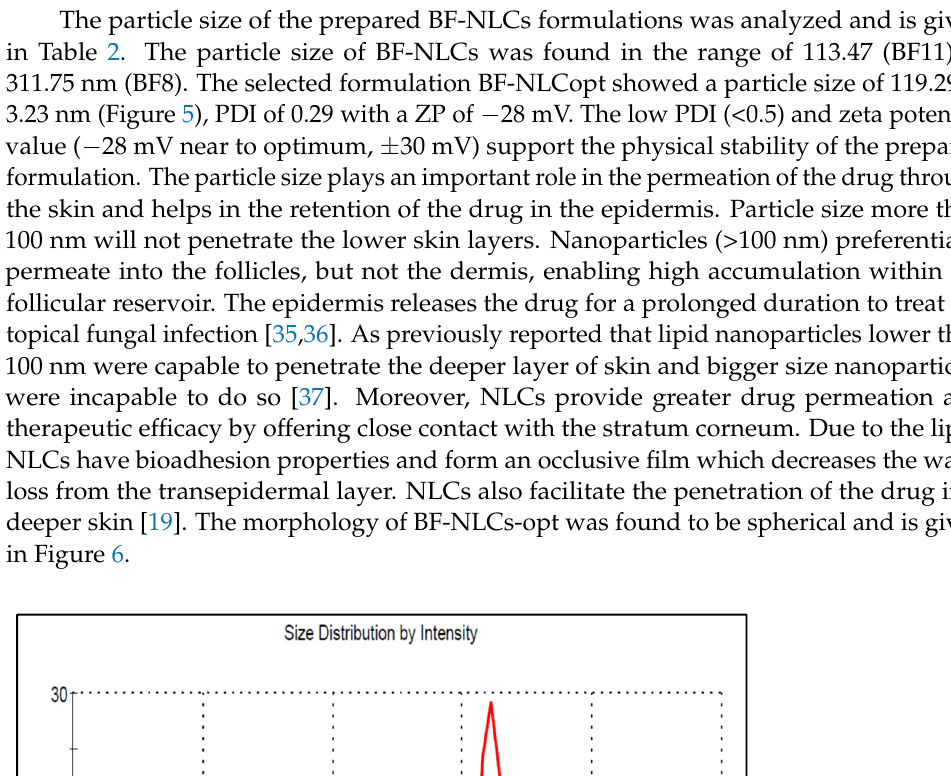
Figure 6. Surface morphology image of BF-NLCopt. 3.8. Entrapment Efficiency The entrapment efficiency of the prepared BF-NLCs was determined by the indirect method and the data are given in Table 2. The maximum entrapment efficiency was found in the formulation BF1 (66.74%) to BF7 (87.42%). The selected optimized formulation BF- NLCopt showed an entrapment efficiency of 86.35 ± 4.11%. The selected formulation showed a drug load of 11.21 ± 0.67%. NLCs were prepared with a blend of solid lipid and liquid lipid. The solid lipid encloses the oil droplets of liquid lipid which solubilizes the greater amount of drug and helps to get high entrapment and loading. The presence of liquid lipid in the NLCs affects the loading and entrapment by creating imperfections in the order crystal structure and gives more space to accommodate a greater amount of drug [23]. 3.9. Formulation of BF-NLCopt Gel Due to the low viscosity of NLCs dispersion, it displays unsuitable rheological prop- erties so it is difficult to apply to the skin layer. To overcome these issues, the low viscosity dispersion system was converted into a hydrogel system to provide precise spatial and temporal control of active ingredient release. Carbopol was selected as the gelling agent